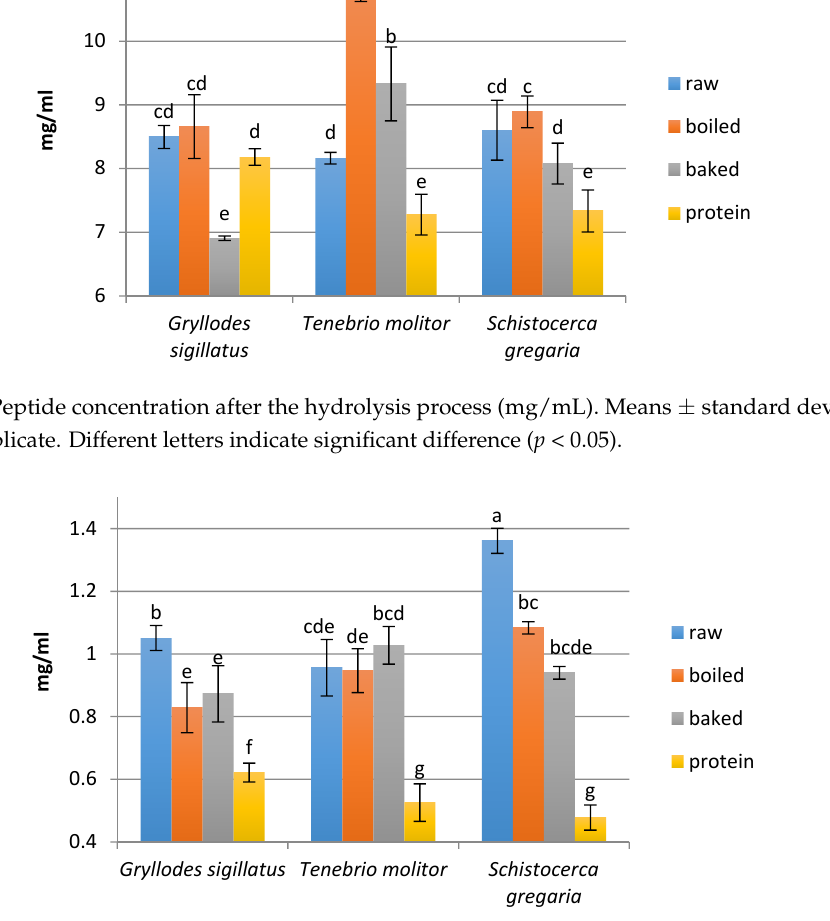
Figure 3. Peptide concentration after the in vitro absorption process (mg/mL). Means ± SD in triplicate. Different letters indicate significant difference ( p < 0.05).